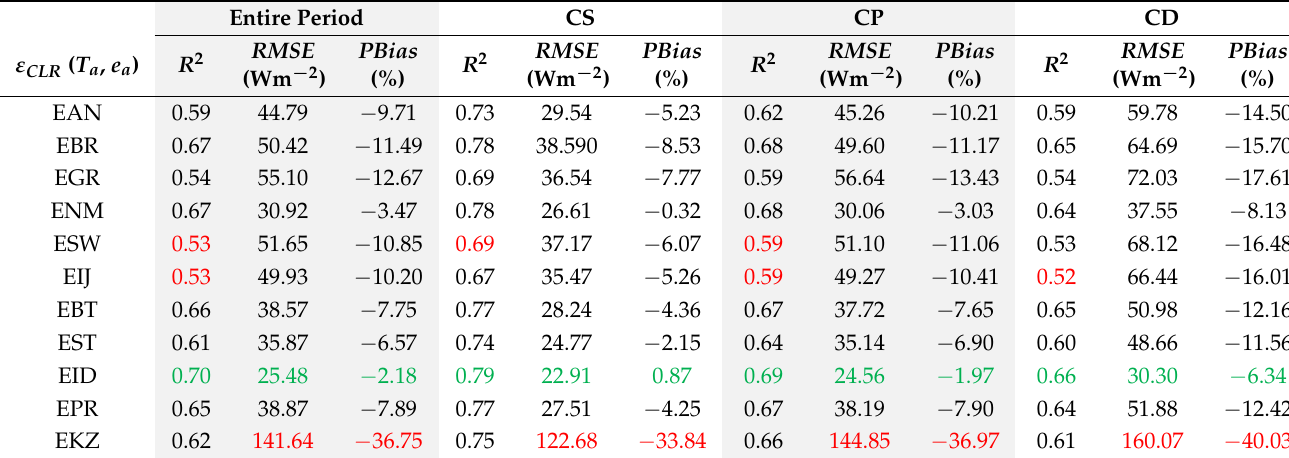
Table 3. Statistical index for the entire period and for different sky coverage classifications for Step 1. The best results are colored in green and the worst in